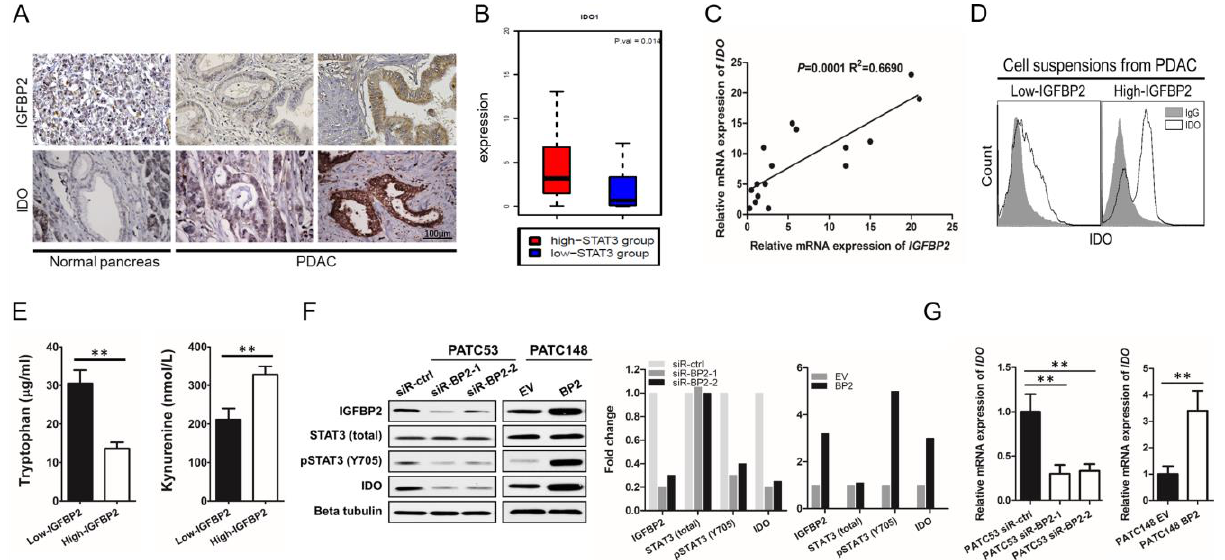
Figure 4. IGFBP2 activates STAT3 and increases IDO expression in human PDAC cells. ( A )